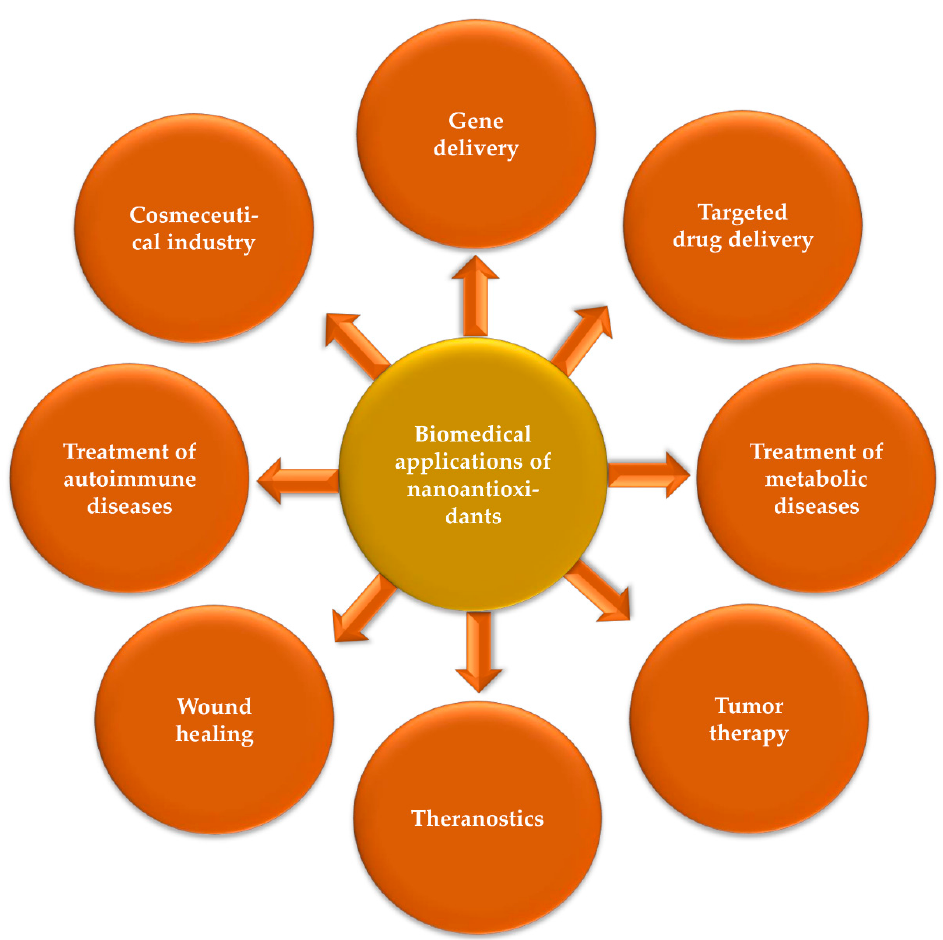
Figure 4. A schematic representation of some of the biomedical applications of nanoantioxidants.